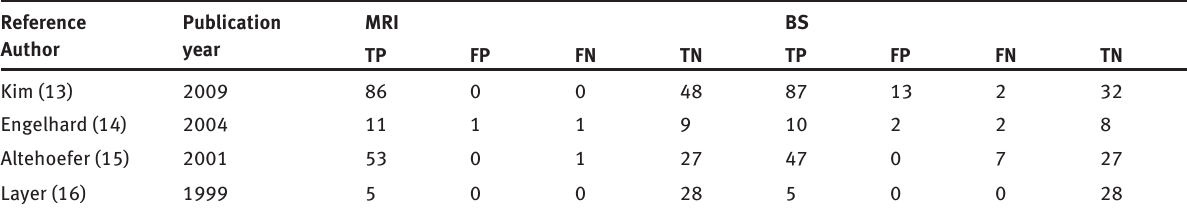
Table 1: Baseline characteristics of included studies